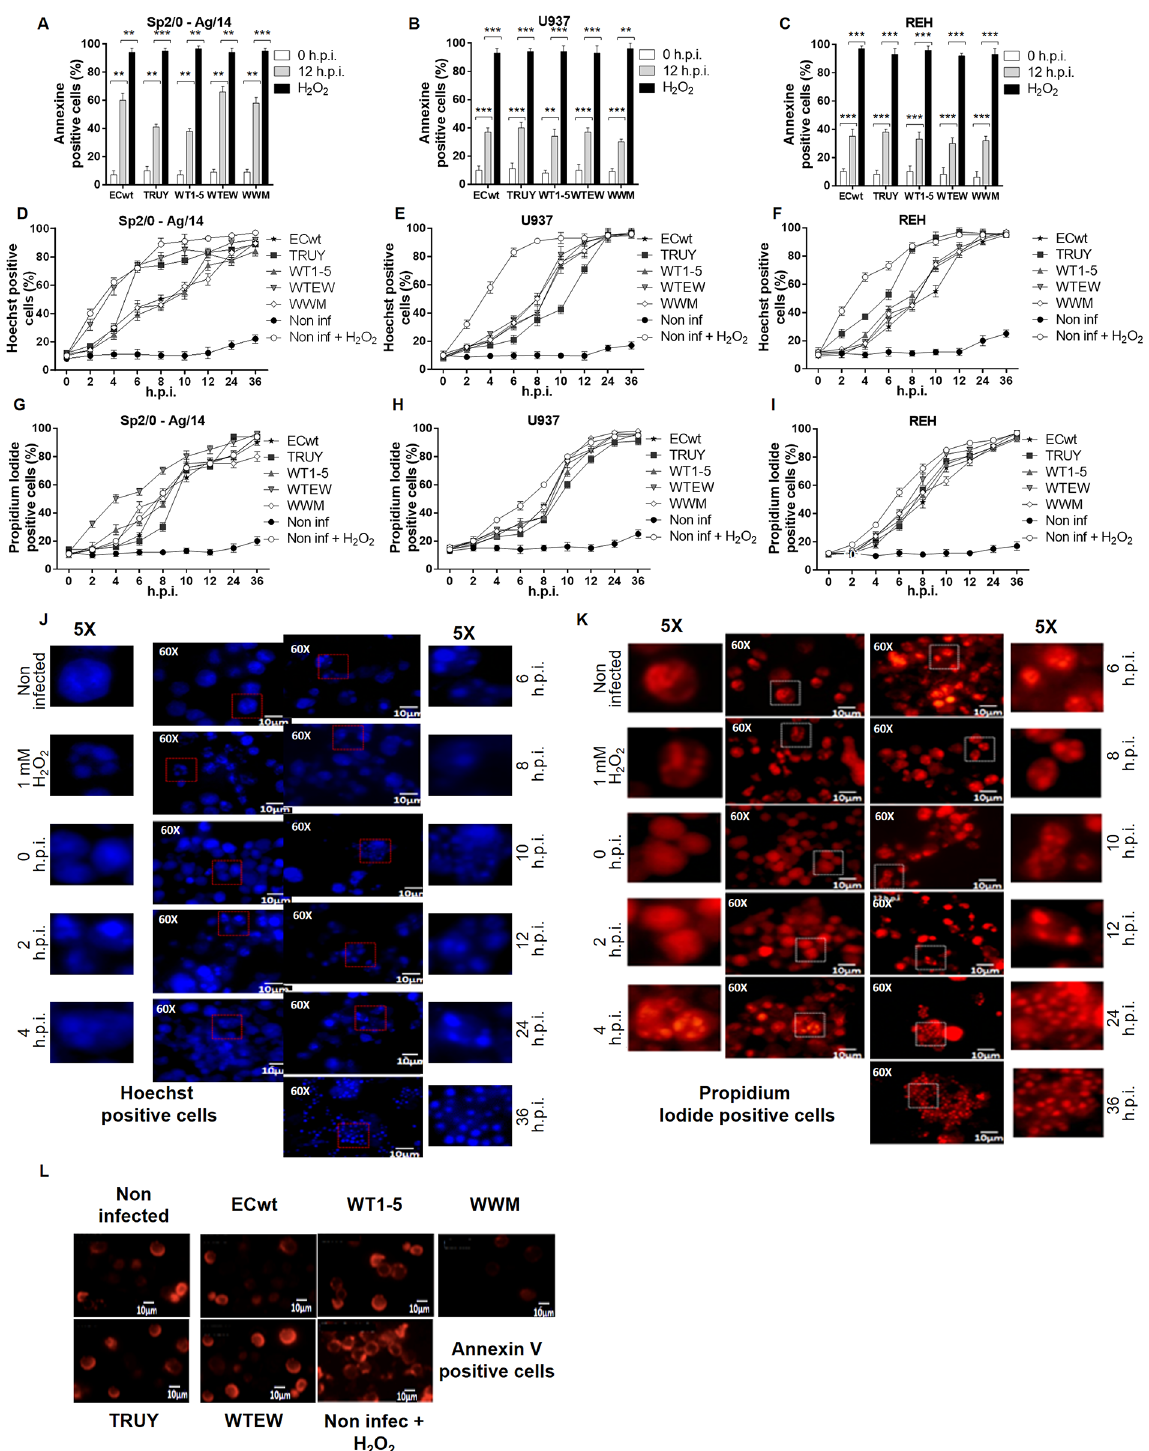
Fig 5. Phosphatidylserine flipping and nuclear morphology alterations induced by infection of rotavirus isolates. (A) Cell lines Sp2/O, (B) U937, and (C) REH were infected with tumor cell-adapted rotavirus isolates WTEW, TRUY, WT1-5, WWM or ECwt at MOI of 0.8. Annexin V expression was assessed at 12 h.p.i. H 2 O 2 treatment was used as a control. Asterisks show statistically significant differences ( *** P < 0.001; ** P < 0.01). (D) Cell lines Sp2/O, (E) U937 and (F) REH were infected as indicated for (A) through (C) , and then collected and fixed every 2 h until 12, 24 or 36 h.p.i. Chromatin condensation and nuclear fragmentation were determined using Hoechst. (G) Cell lines Sp2/O, (H) U937 and (I) REH were also examined with propidium iodide for their